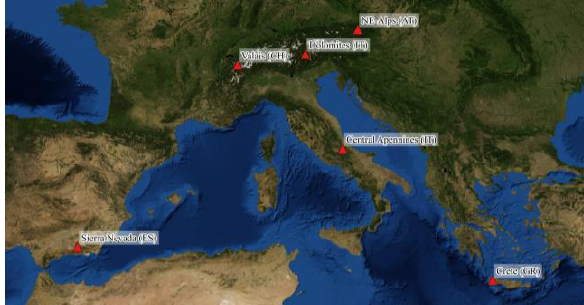
Figure 1. Overview of test regions in the Alps and the Mediterranean mountains (Basemap: MaqQuest)